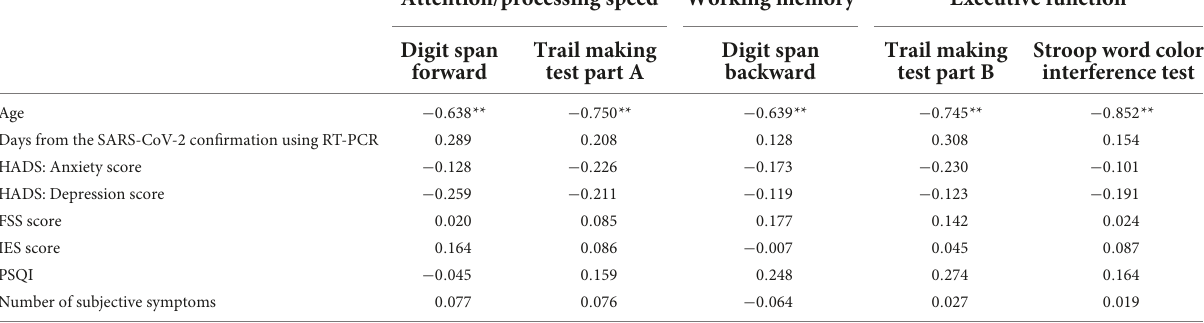
TABLE 4 Correlation between the T scores in the cognitive tests and clinical characteristics.